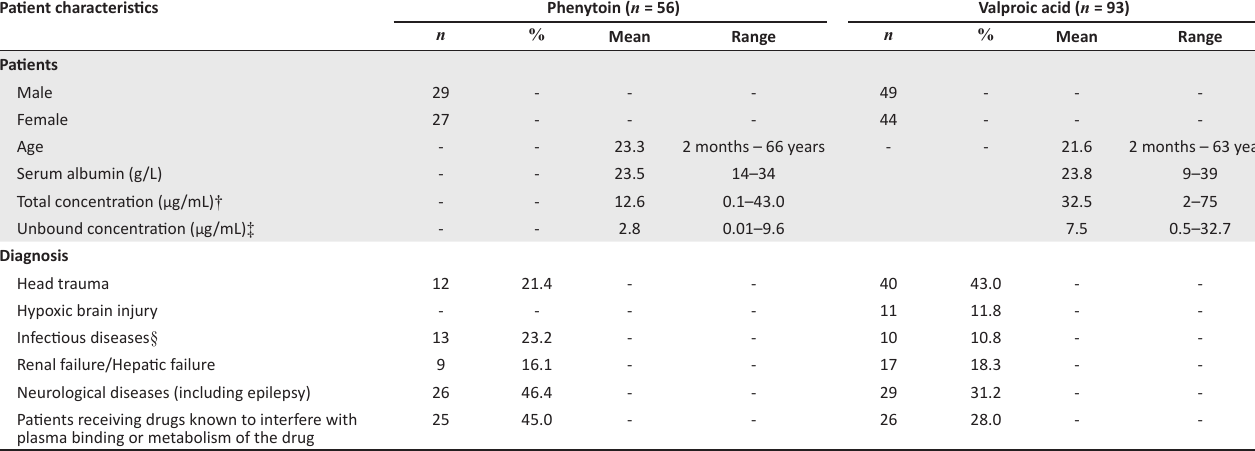
TABLE 1: Patient characteristics and total and predicted plasma concentrations of phenytoin and valproic acid in critically ill patients in the Intensive Care Unit at Windhoek Central Hospital (Windhoek, Namibia) from 2013 to 2019. Patient